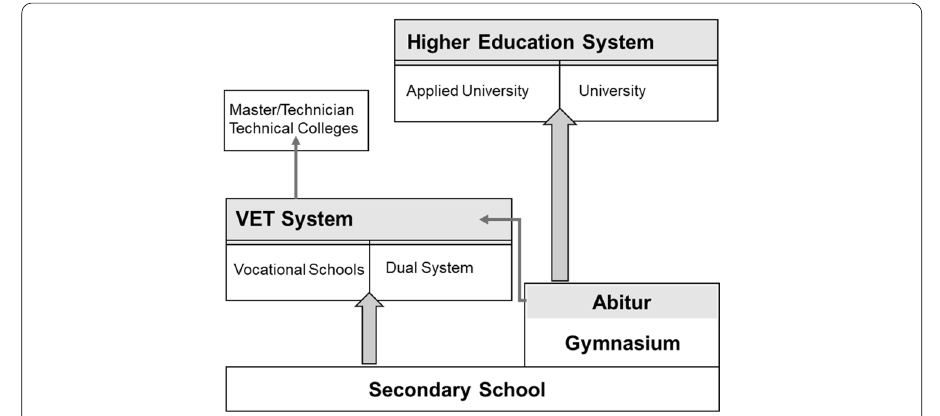
Fig. 1 The German education system and its educational tracks (Source: Own